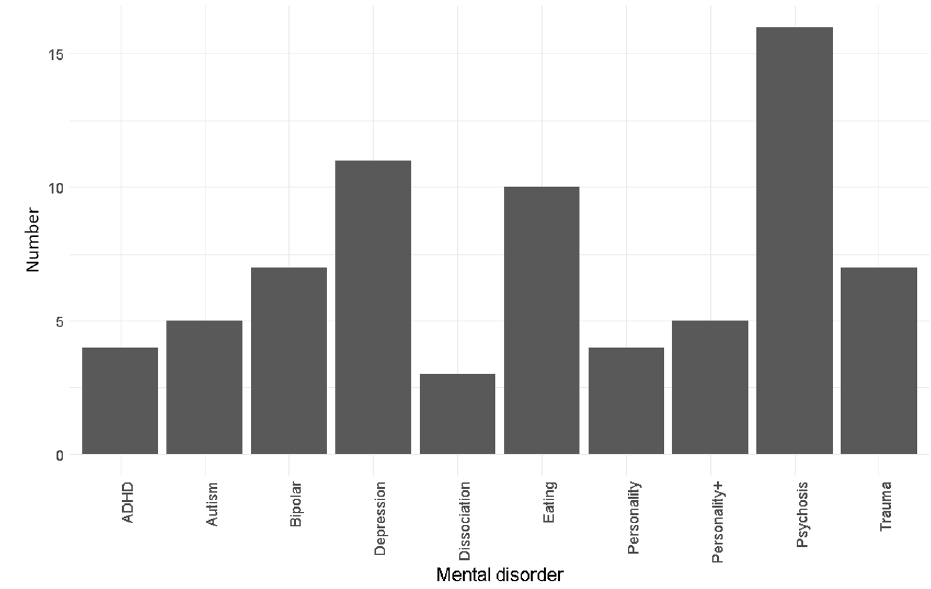
Figure 1. Columnchart of number of people per mental disorder in the